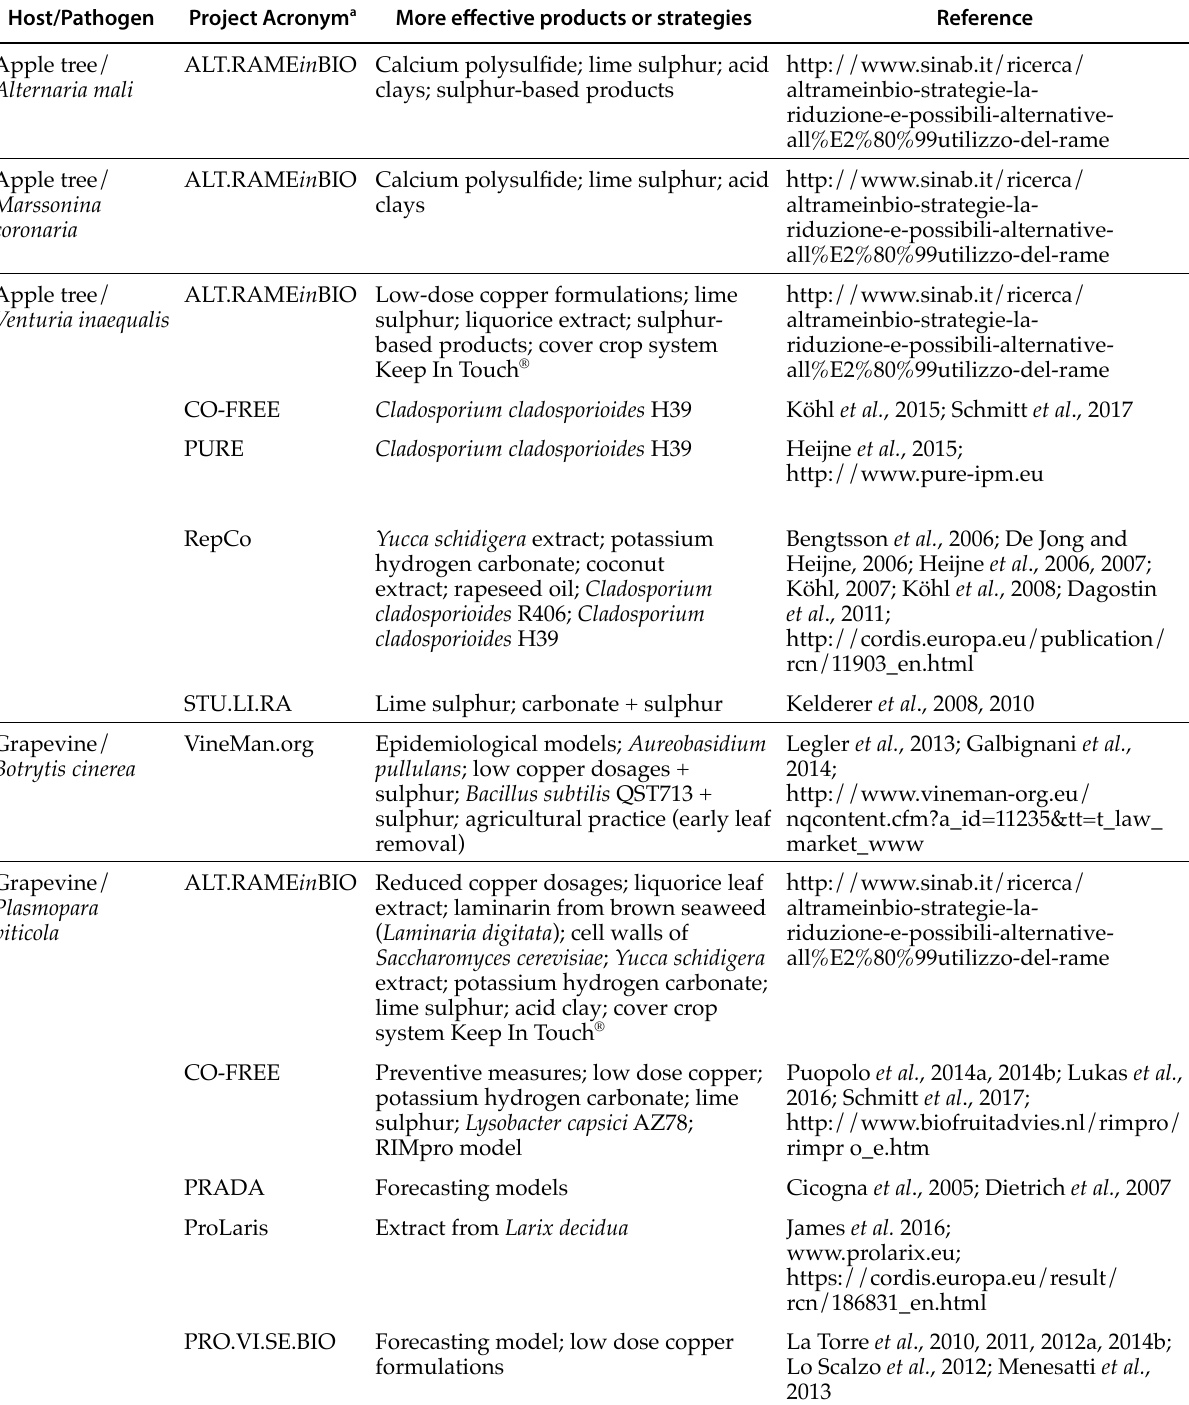
Table 5. The principal features of projects on copper carried out in recent